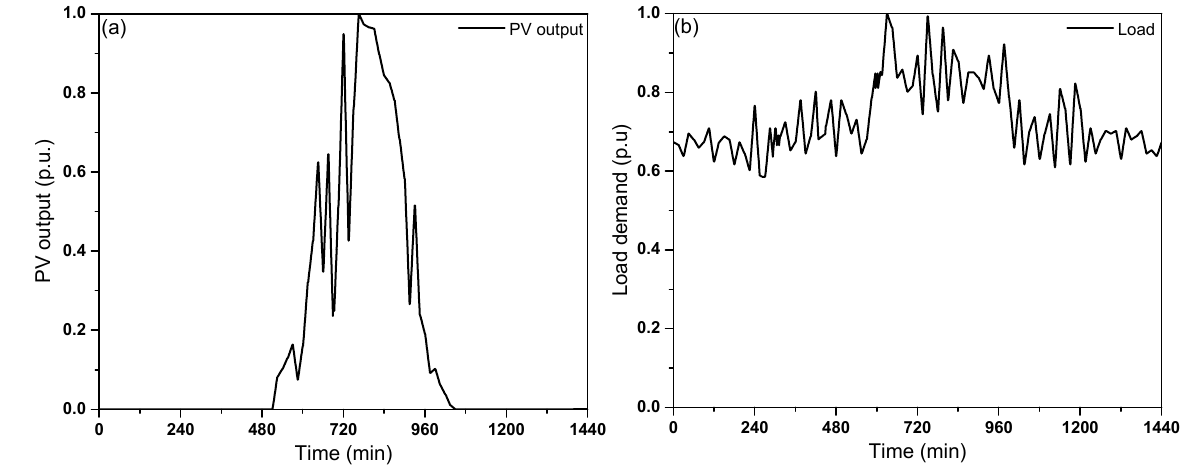
Figure 7. One-day pattern of the load ( b ) and PV ( a ). Table 2. Parameters of the test model.